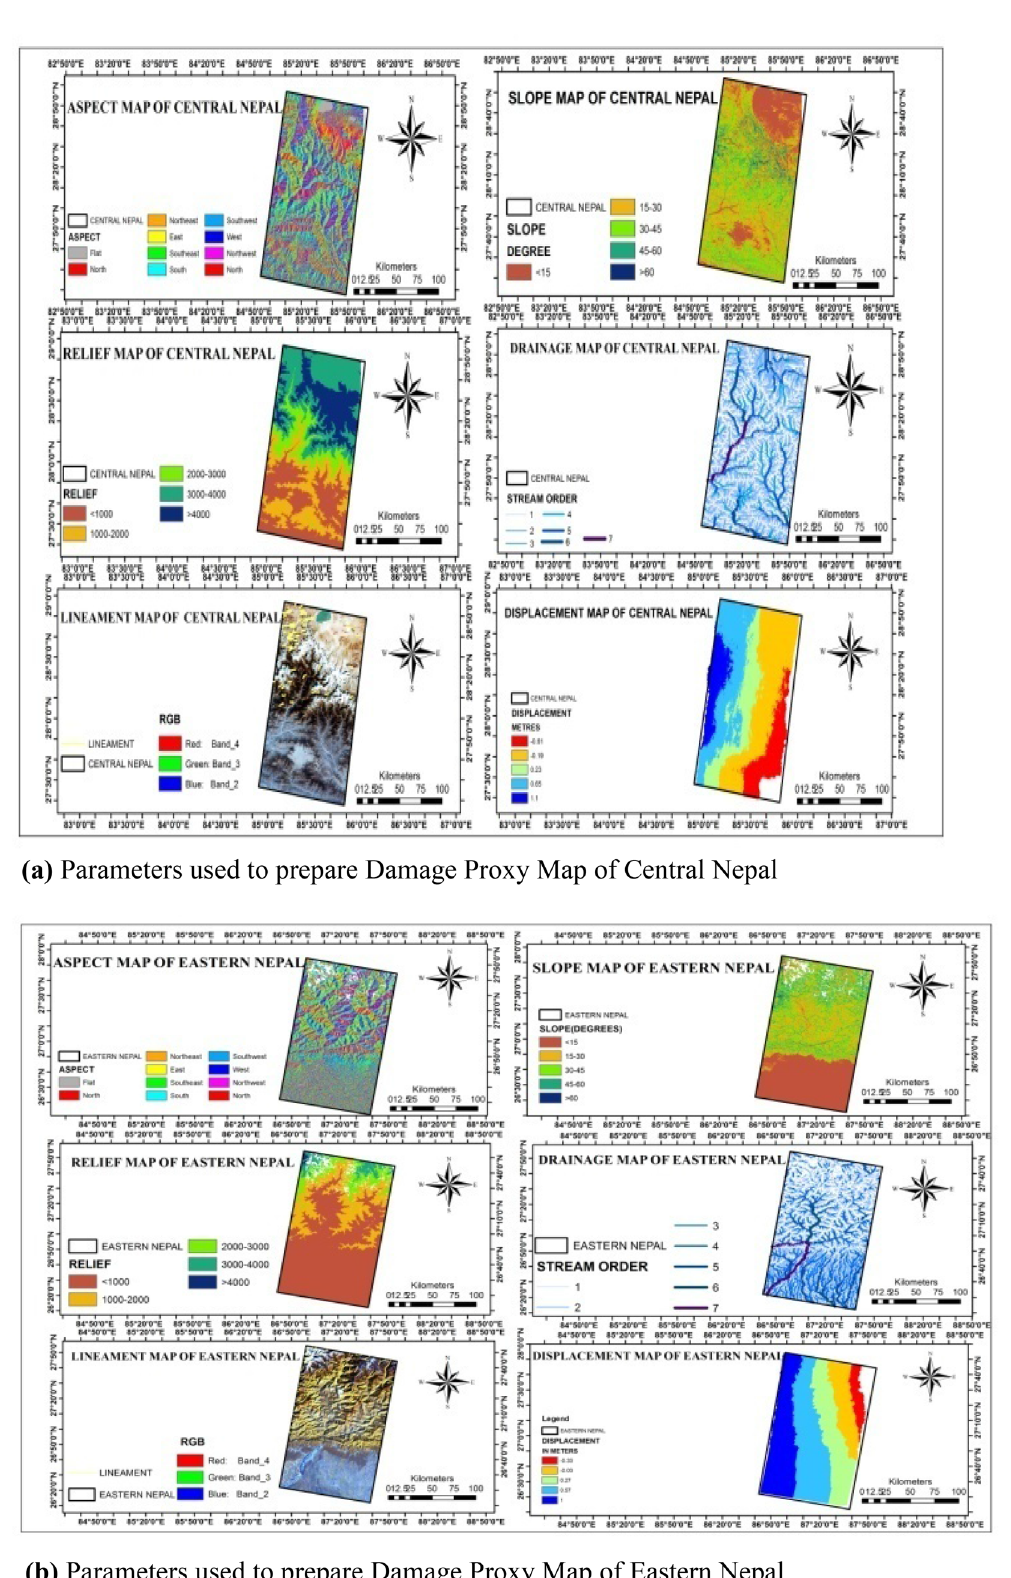
Fig. 8 a Parameters used to prepare Damage Proxy Map of Central Nepal. b Parameters used to prepare Damage Proxy Map of Eastern